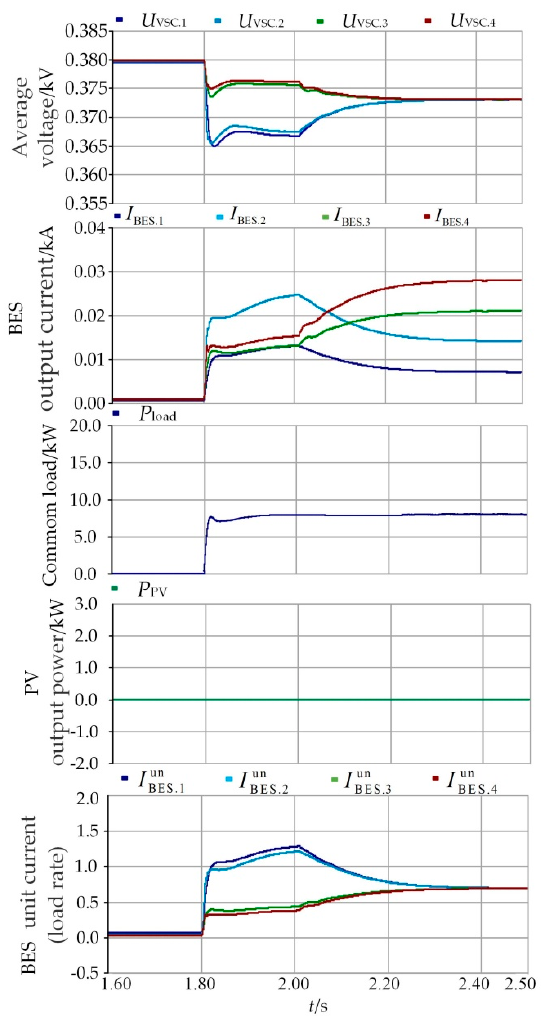
Figure 13. Verification for the effectiveness of DDCA convergence.